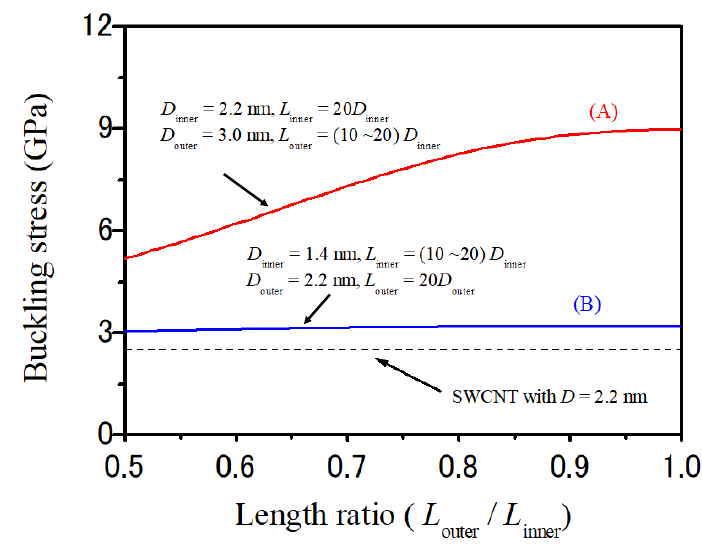
Figure 18. Variation of the buckling stress of DWCNTs with the length ratio for the first bending mode 1. Adapted with permission from [77], Copyright Elsevier, 2011.